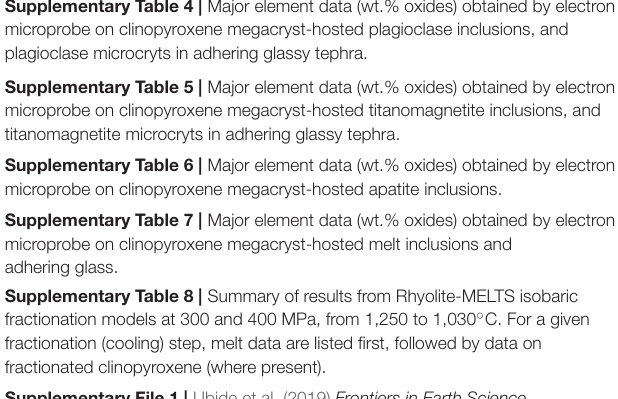
( Figure 8 ) is denoted by the large square symbol. The compositional fields for all Stromboli whole rocks and Eruptive Epoch 6 whole rocks are provided for comparison (Francalanci et al., 2013). The compositional fields for glass data from Pizzo and Present-day activity products are also provided (Francalanci et al.,